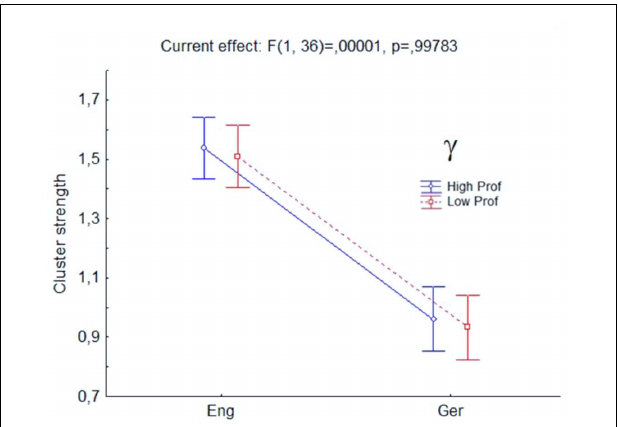
FIGURE 3 | Synchronization cluster (strength) analysis by “Coarse-Graining Markov Chains” (CGMC) within the ( γ ) gamma-band (30–45Hz) showed significant differences between native language German (Ger, x -axis), cluster strength ( y -axis) around 0.9, and second language English (Eng) with cluster strength significantly higher (around 1.5). Red line denotes the low proficiency and blue line the high proficiency